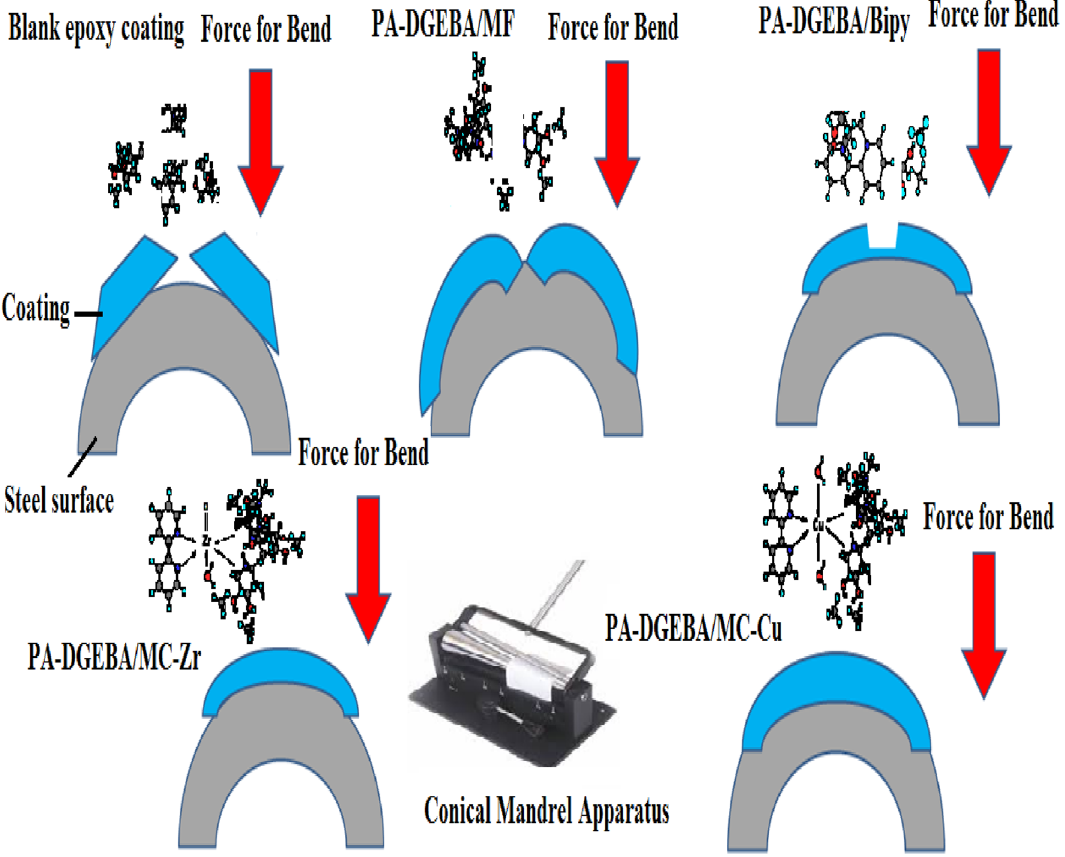
Figure 12. Sketch illustrates the expected behavior of the investigated coated steel samples after applying the bend